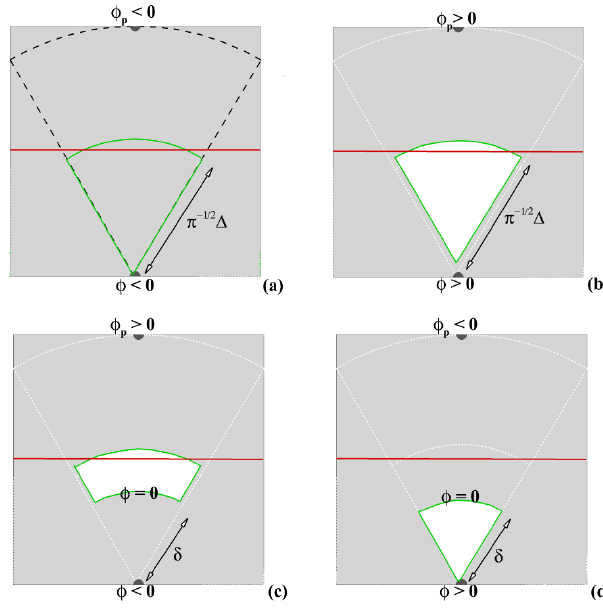
(cid:94) (cid:49) 2 u i ∗ calculations depending on the signs of Figure 6. (a–d) ± φ i = (φ) and φ p on an arbitrary piece of cake. The white (grey) region corresponds to the solid (fluid) one of P ∗ p (same color code as in Fig. 5).